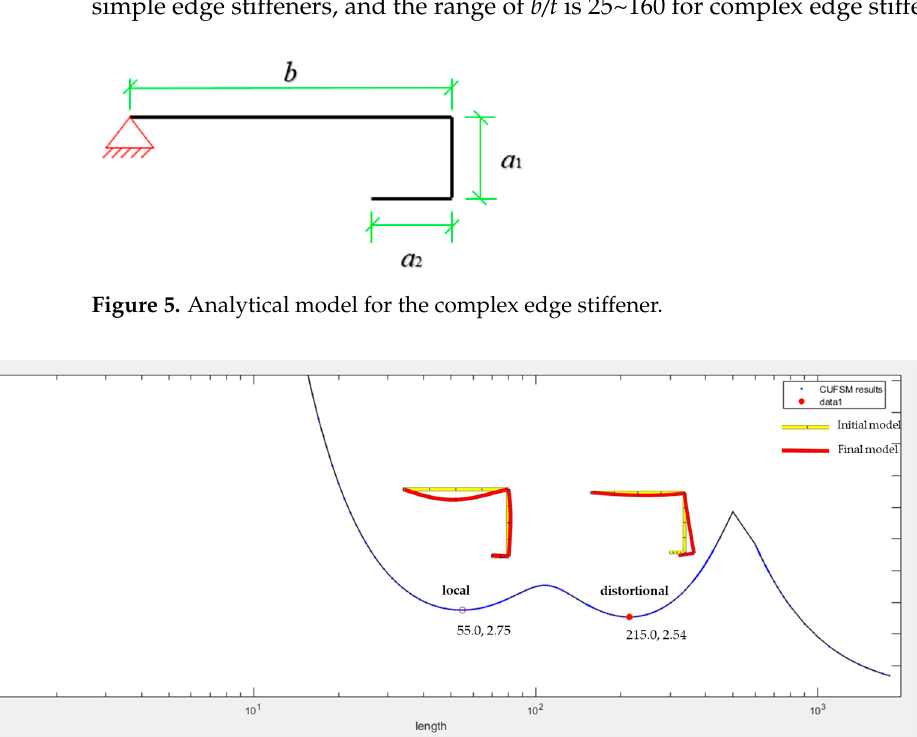
Figure 8. Values of l/t of the complex edge stiffeners for different a 2 / a 1 ratios. When a/t and b/t are the same, the half ‐ wavelength of the complex edge stiffeners is smaller than that of the simple one, and the range less than the width of the flanges is larger, as shown in Figures 3 and 8. When the flange is constrained sufficiently, the local buckling half ‐ wavelength is approximately equal to the width of the flange. When the restraint is insufficient, the complex edge stiffener has a stronger ability and wider range to provide sufficient restraint for the flange compared with the simple edge stiffener. Among them, the phenomenon, for a 2 : a 1 = 0.25, that the buckling half ‐ wavelength rises abruptly is due to the deformation being dominated by distortional buckling when the distortional critical buckling stress is less than the local critical buckling stress, as shown in Figures 6 and 8. 0